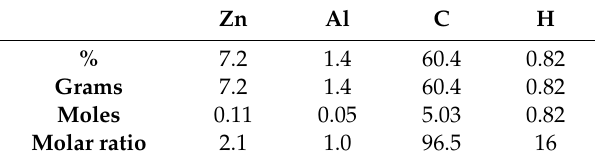
Table 1. Values for elemental analysis of ZnAl-CNTs.